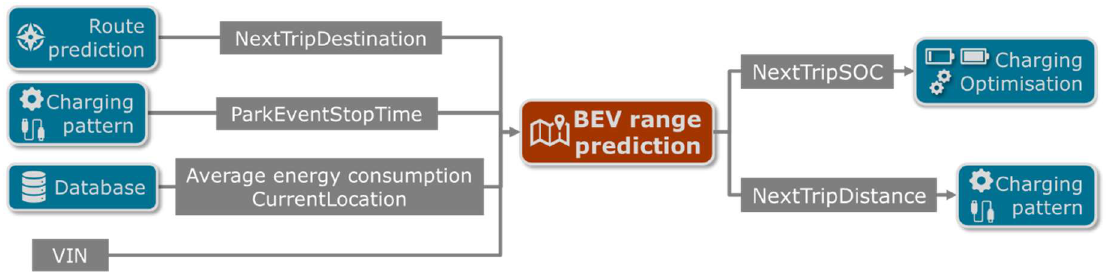
Figure 9. BEV range prediction algorithm interaction.